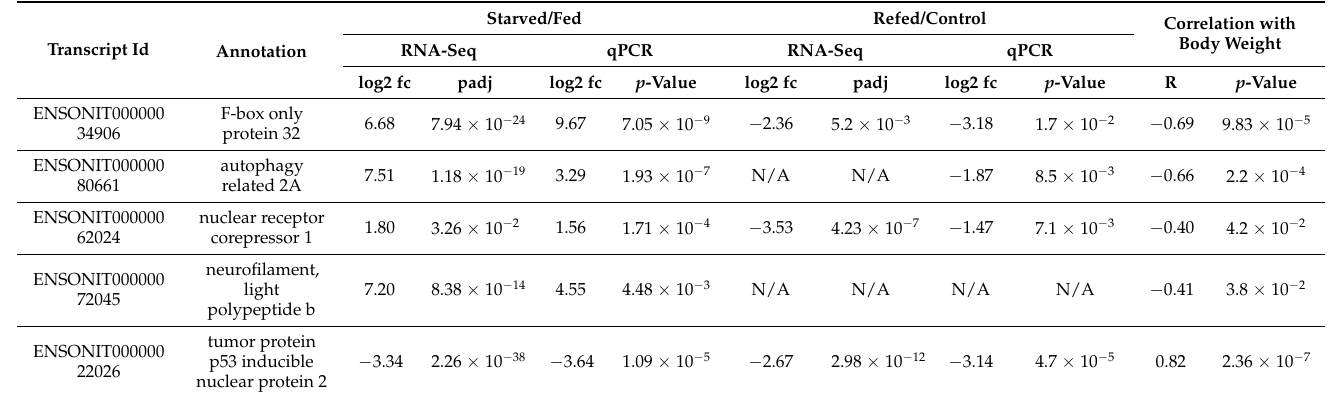
Table 1. qPCR quantification revealed consistency with the RNA-Seq (R = 0.89; p -value 0.003). Correlation between the transcript relative expression level and body weight was performed by real-time PCR in 31 individual fish. Negative R values ( − ) indicates negative